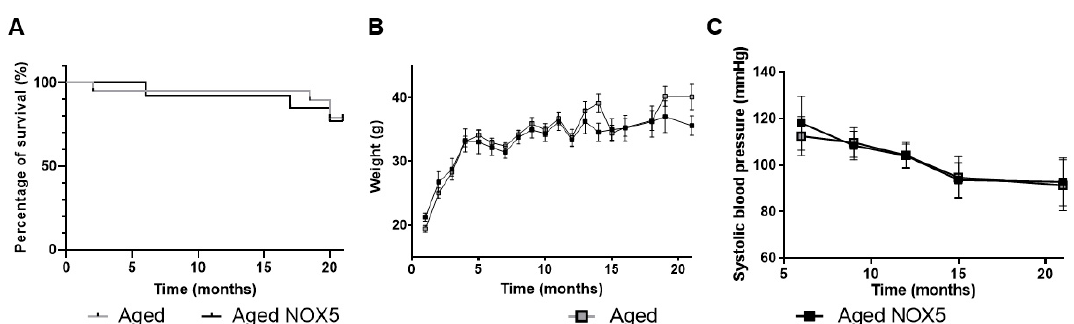
Figure 3. Phenotypic characterization of the aging knock-in mouse model. ( A ) Percent of survival in the aging mice ( Aged and Aged NOX5 ). n = 13–19. ( B ) Mice weight (g) evolution in the Aged and Aged NOX5 groups. n = 13–19. ( C ) Systolic blood pressure (mmHg) alterations in the Aged and Aged NOX5 groups. n = 13–19. The results are expressed as the mean ± SEM. Aged : CRE +/ − aging mice and Aged NOX5 : NOX5 +/ − CRE +/ − aging